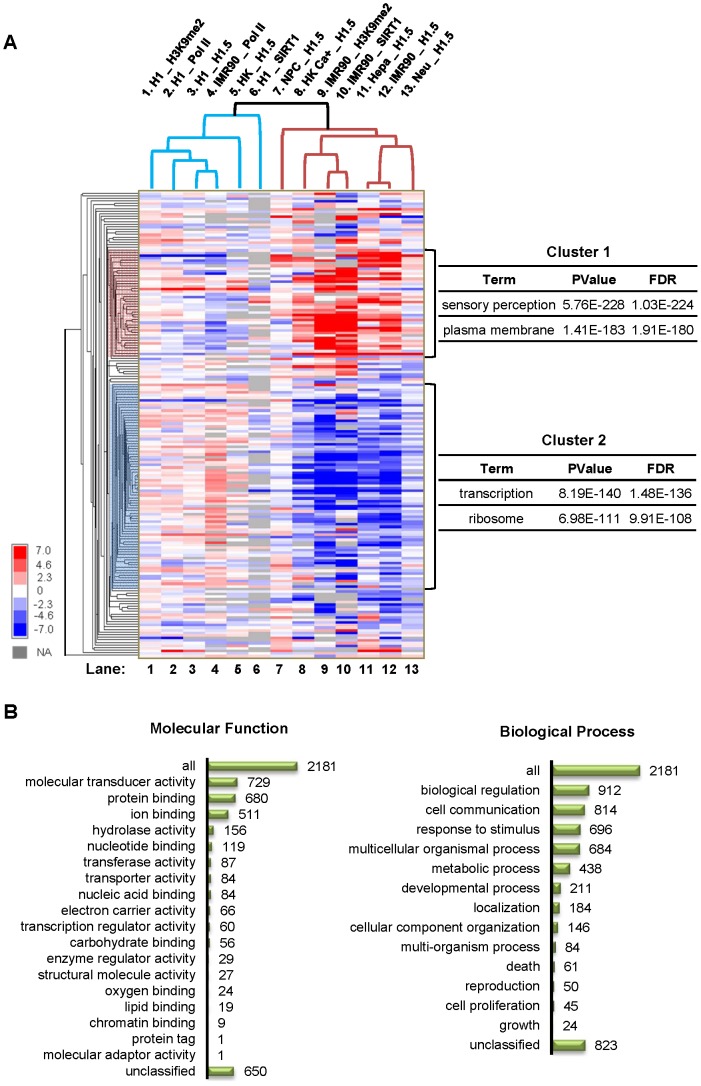
H1.5 enrichment in HGNC gene families.(A) Hierarchical clustering of H1.5 enrichment levels in HGNC gene families is shown as a heat map. Enrichment z-score of each gene family was calculated by averaging the intensities of probes within a gene family region corrected for number of probes. Each row represents a gene family, and each column represents an experiment. The main sub-clusters of gene families are highlighted on the left and the most enriched gene ontology terms for each cluster are shown on the right. (B) Ontology classification of genes in cluster 1 families. Number of genes in each category is indicated.